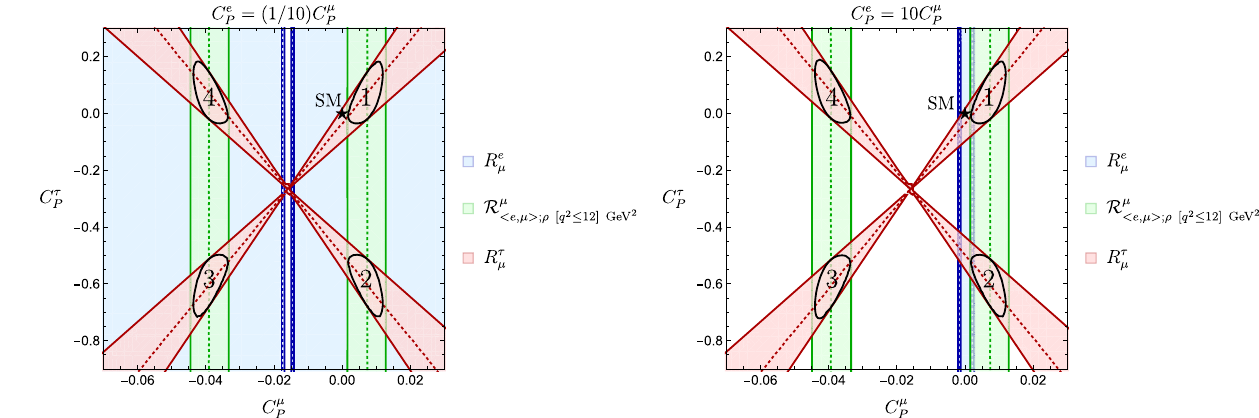
Fig. 17 Regions allowed for C Table 2 Summary of the determination of | V ub | and the predictions for B ( B − → e − ¯ ν e ) (cid:27) B ( ¯ B → ρτ − ¯ ν τ ) and different scenarios discussed in the